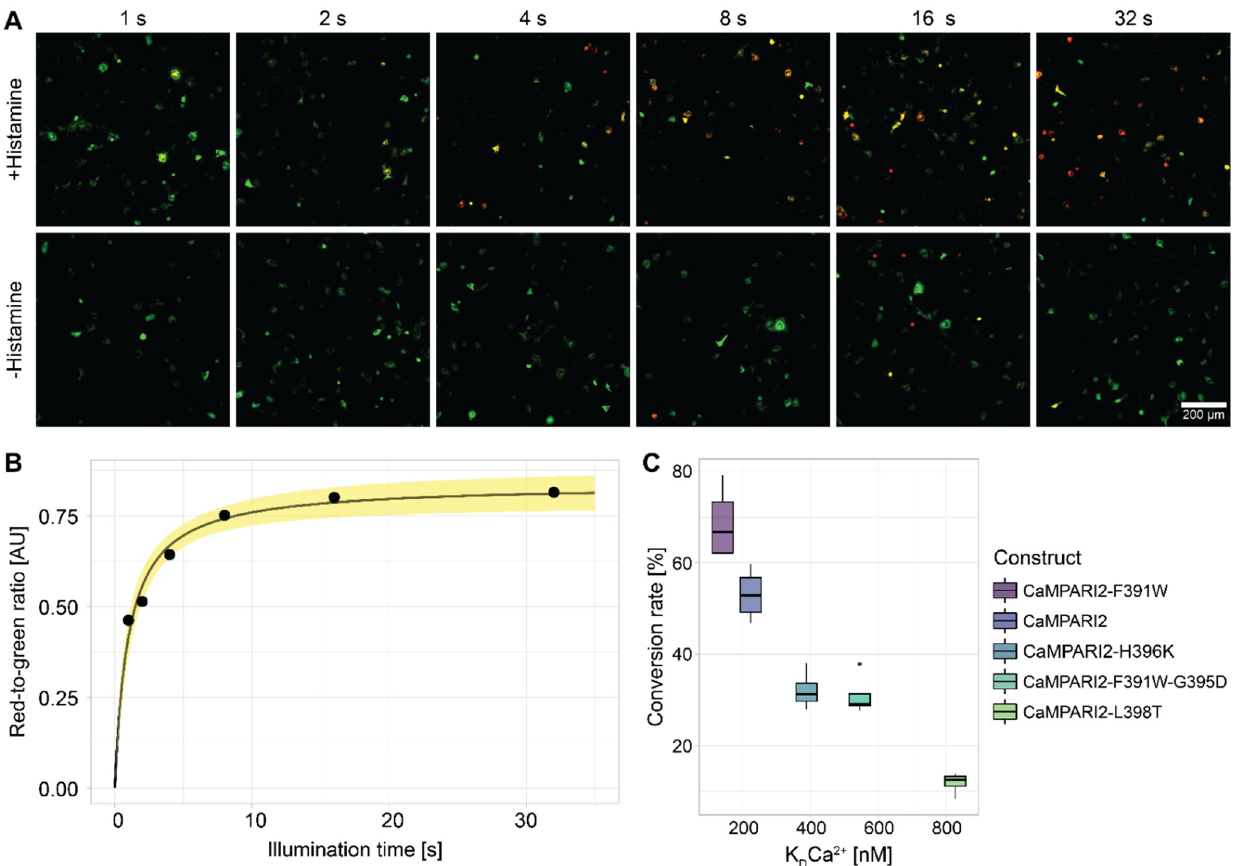
Figure 3. Time course of photoconversion illumination over 32 s and conversion rates of different CaMPARI2 ‐ variants in C28/I2 chondrocyte cells in response to histamine treatment. C28/I2 cells transfected with Lipofectamine 3000 and 100 ng of pMAX_CaMPARI2 ‐ F391W ‐ G395D plasmid DNA were treated with 100 μ M histamine and illuminated for different durations with 1.1 W 405 nm LEDs. ( A ) C28/I2 chondrocytes imaged by a Zeiss LSM780 laser scanning confocal fluorescence microscope. Scale bar = 200 μ m. Green signal: excitation wavelength 488 nm, Argon 25 mW, detection range 490–588 nm, laser intensity: 3%; red fluorescence: excitation wavelength 561 nm, DPSS 561 10 mW, detection range 578–696 nm, laser intensity: 10%; Objective: Plan ‐ Apochromat 10x/0.3 M27; Pinhole size: 2 AU; Pixel pitch: 1.66 μ m; Pixel dwell time: 13 μ s; Averaging: (8) Red and green fluorescence signals were merged to show the conversion ratio of green to red CaMPARI2. ( B ) The average intensity of red fluorescence divided by green fluorescence fitted with a saturation curve. The yellow area indicates the 90% confidence interval of the saturation curve. ( C ) Cells of the C28/I2 human chondrocyte line were transfected with five different constructs of CaMPARI2 using Lipofectamine 3000. Two days after the transfection, the cells were treated with 100 μ M histamine and incubated for 15 s, followed by a 4 s long 405 nm photoconversion light from LEDs with 1.1 W radiant flux. The conversion rate is defined as the percentage of CaMPARI2 ‐ transfected cells showing the conversion from green to red fluorescence divided by the total number of fluorescent cells.